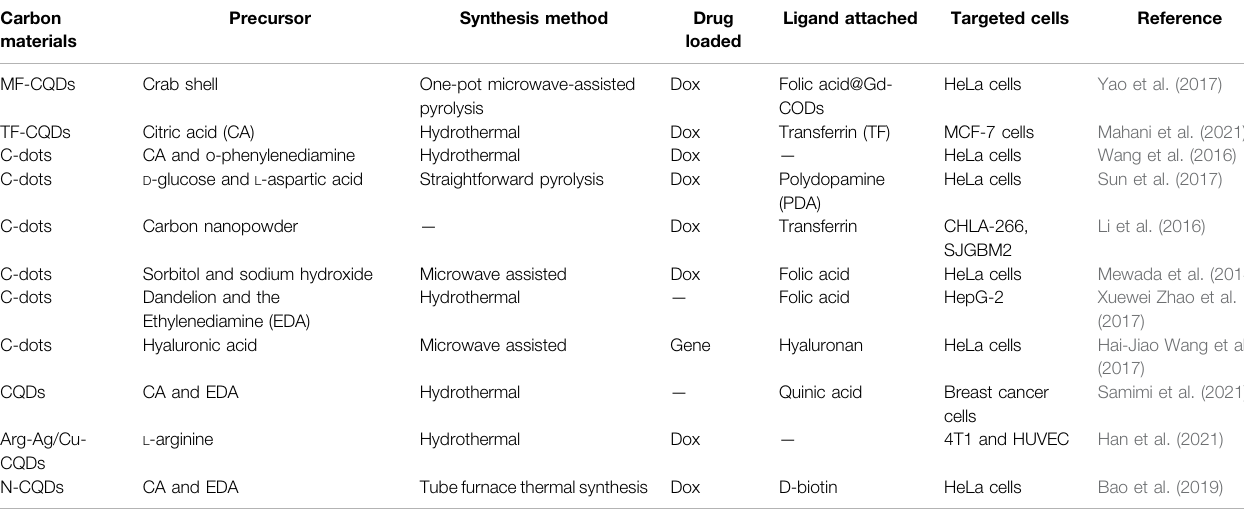
TABLE 3 | Information of various drug delivery applications using CQDs and various synthesis